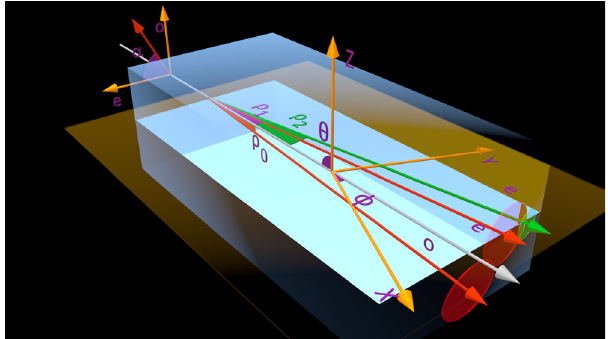
Fig. 1 Graphical illustration of beam propagation in potassium titanyl phosphate (KTP) crystals. The fundamental frequency (FF) ordinary (o), FF extraordinary (e), and the second harmonic (SH) beams have different walk-off angles, ρ 0 , ρ 1 , and ρ 2 , respectively. The orientation of the reference frame with respect to the crystallographic axes X, Y, and Z is identi fi ed by the angles θ and φ . The orientation of the input linear polarization of the light beam is measured by the angle α .